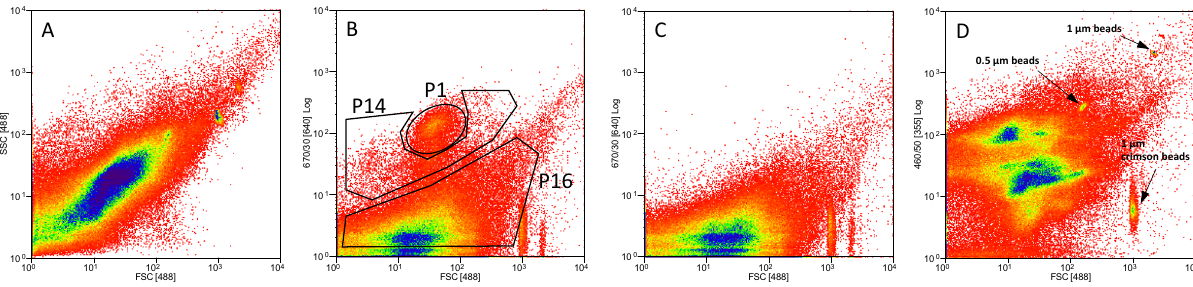
Fig. 7 Flow cytometry (FC) analysis. FC of a fi xed activated sludge (AS) sample hybridized with a Bdellovibrio-speci fi c BDE525-Cy-5' probe. A In the forward scatter (FSC)/side scatter (SSC) detection mode. B In the FSC/ fl uorescence (670/30[640]) (Fl) mode. Gates P1 and P14 de fi ne regions containing events positive for the BDE525 fl uorescent signal. Gate P16 is signal-negative; C Fixed AS sample hybridized with a NonBDE525 probe, in the FSC/Fl mode, and; D Fixed AS sample hybridized with a Bdellovibrio -speci fi c BDE525 probe, counter-stained with DAPI, in the FSC/ fl uorescence (460/ 50[356]) mode. Beads were used for the calibration and quanti fi cation of predator